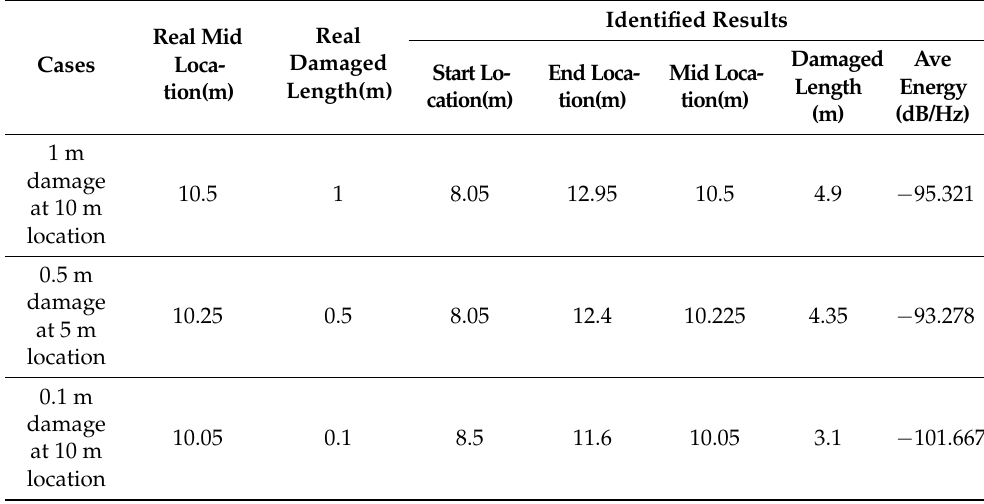
Table 3. Comparison of STFT results of bridges with different damage